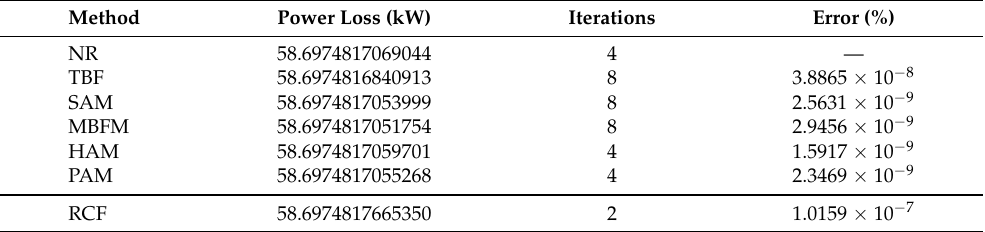
Table 2. Power flow solution for the 85-bus grid using different methodologies.